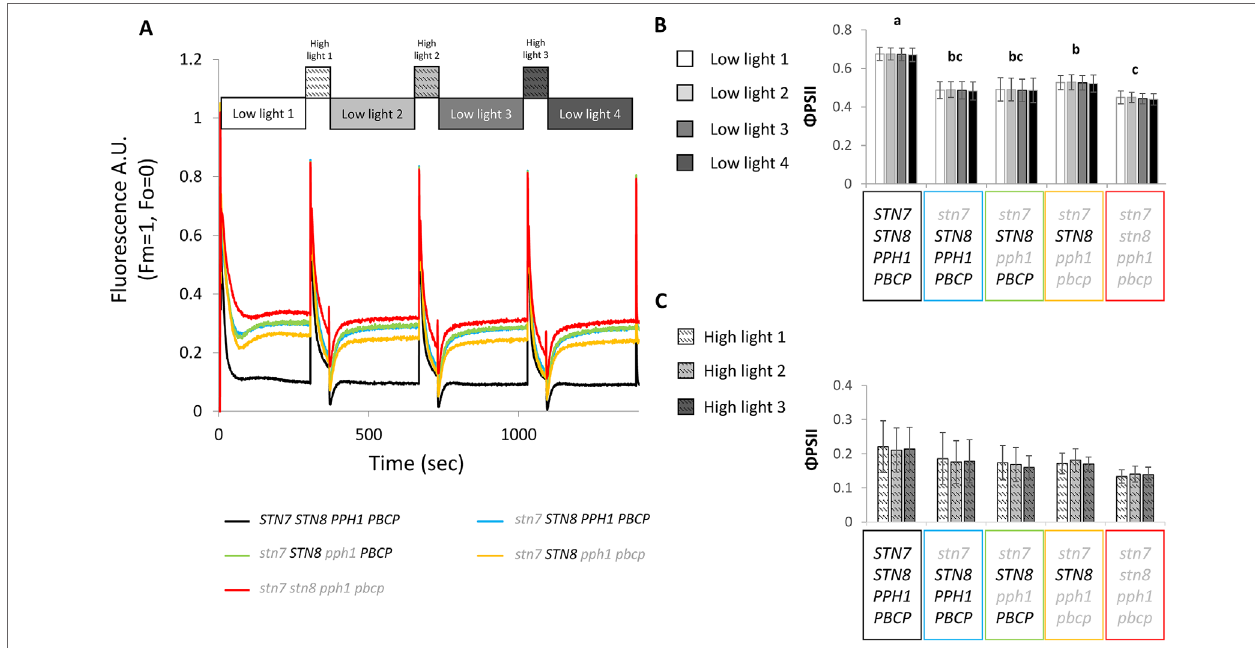
FIGURE 5 | Room temperature fluorescence analysis under a fluctuating light regime. Plants grown under continuous white light (100 µmol photons m −2 s −1 ), were exposed to a variable light intensity regime of blue light (450 nm) composed of 4 min of low light (50 µmol photons m −2 s −1 ) and 1 min of high light (500 µmol photons m −2 s −1 ) in a FluorCam (MF800 PSI - PhotoSystems Instruments). (A) The graph shows the average of the room temperature fluorescence measured during this period for the different lines, the values have been normalized on F M = 1 and on F O = 0 (n = 5). (B) Values of the operating efficiency of photosystem II photochemistry ( Φ PSII) calculated for the Col0 and mutant lines at the end of each low light phase Statistically different groups are marked with different letters (Student t test P < 0.05) error bars represent the standard deviation (n = 5). (C) Values of Φ PSII calculated at the end of each high-light phase. In both graphs the error bars represent the standard deviation (n =